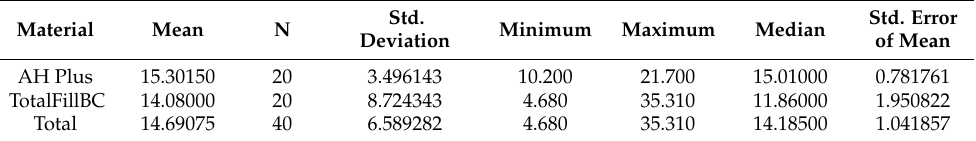
Table 2. Mean values and SD of volume (in mm 3 ) of root canal filling in the two experimental groups before retreatment. Table 3. Mean values and SD of the volume (in mm 3 ) of root canal filling in the two experimental Material Mean groups and root canal remnants after root canal retreatment were determined by micro-CT